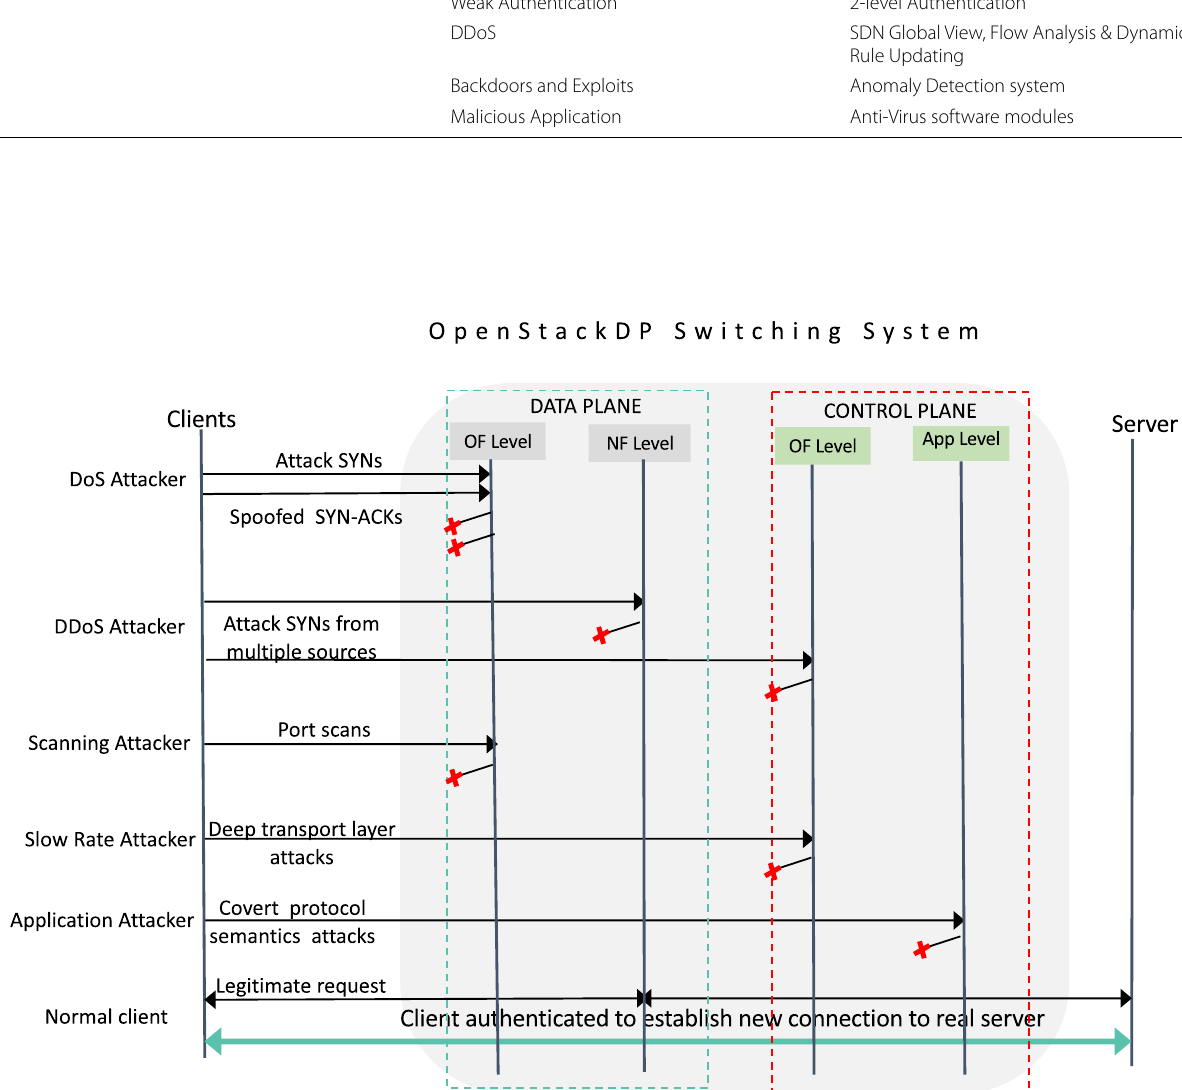
Fig. 33 Depth traveled by attack traffic in the